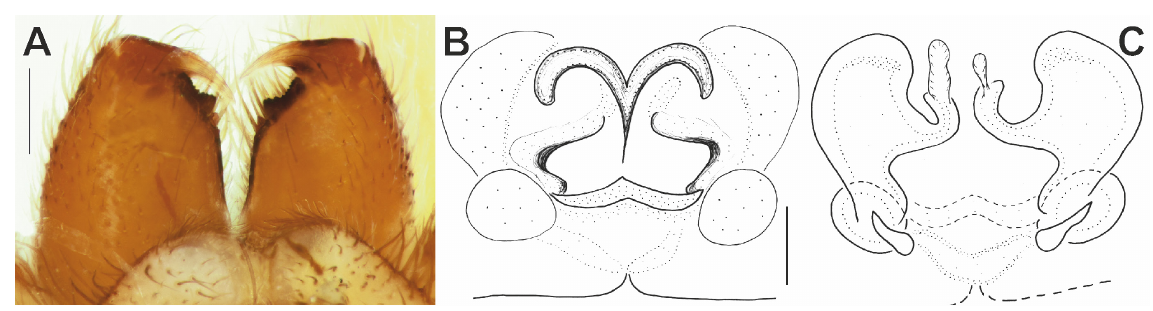
Fig. 4. Berlandina mesopotamica Al-Khazali, 2020, ♀ (MHNG). A . Chelicerae, posterior view. B–C . Epigyne, ventral and dorsal views. Scale bars: A = 0.2 mm; B–C = 0.1